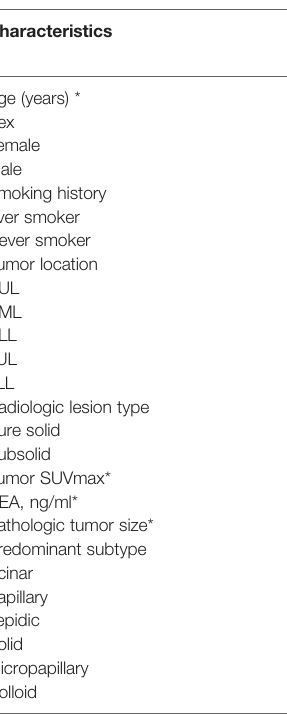
TABLE 1 | Baseline characteristics of